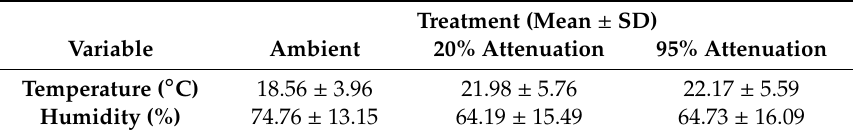
Table 1. Microclimatic measurements for tunnel house and ambient